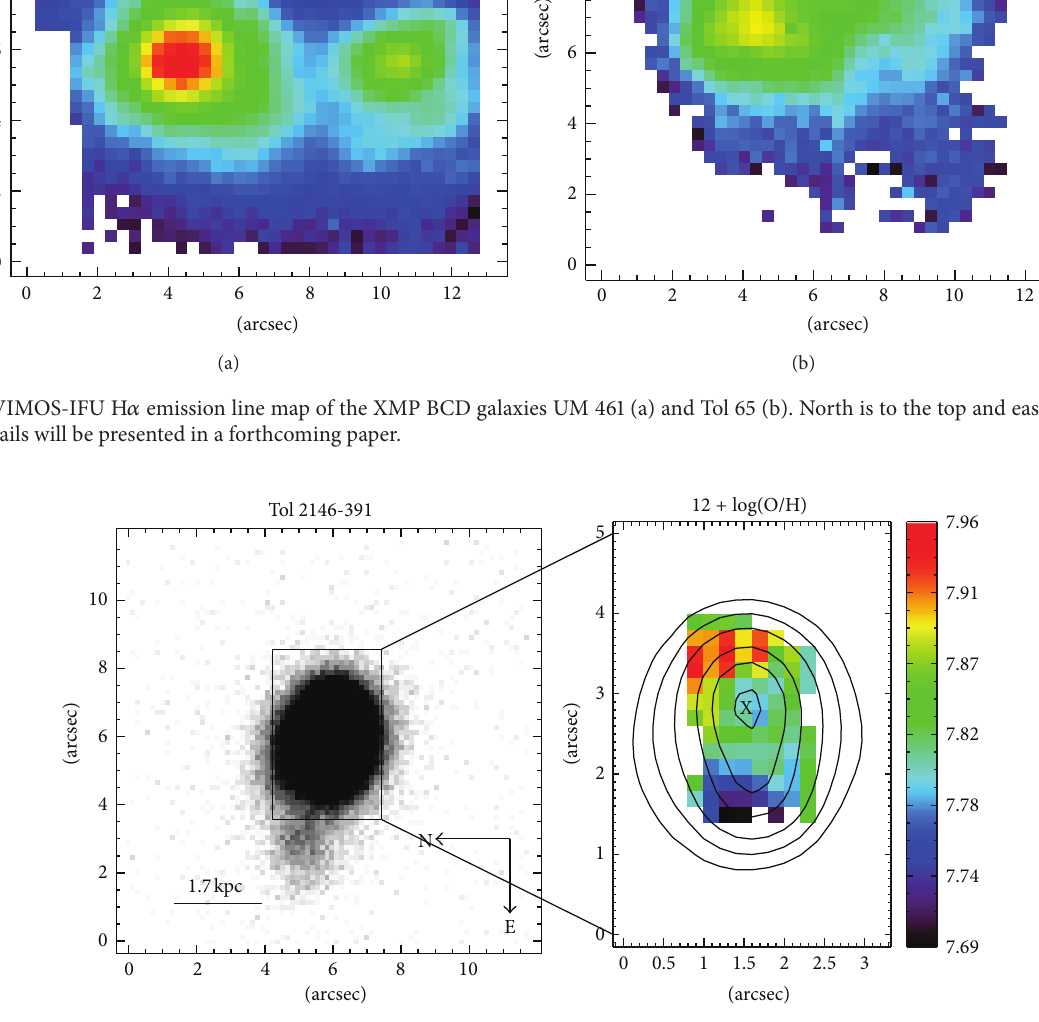
Figure 4: Spatial distribution of oxygen abundances in the galaxy Tol 2146-391. Left: g-band acquisition image of the galaxy. The rectangle indicates the FoV of 3 󸀠󸀠 .5 × 5 󸀠󸀠 covered by our GMOS-IFU observation. Right: 12 + log(O/H) spatial distribution. The isocontours display the H 𝛼 emission. The maximum H 𝛼 emission is indicated in the maps by an X symbol. We considered spaxels with signal-to-noise ratio (S/N) > 3 in the [OIII] 𝜆 4363 line. More details in